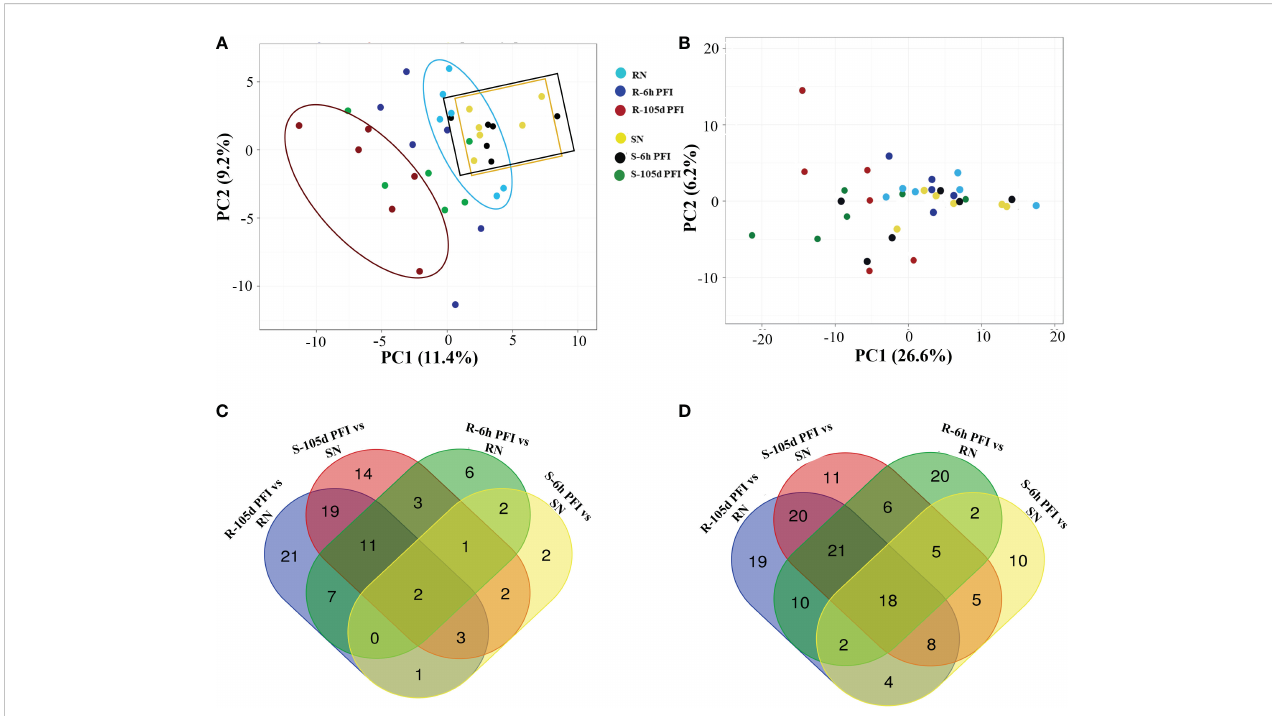
FIGURE 2 The effect of tick infestation on serum and skin proteomes of resistant and susceptible Brangus cattle. Principal component analysis (PCA) of the log 10 protein abundances normalised to a total protein abundance in each group for serum (A) and skin (B) samples; coloured by tick phenotype and the sampling time point: tick resistant naïve (RN) = light sky-blue, tick resistant after 6-hour post- fi rst infestation (R-6h PFI) = blue, tick resistant (R-105d PFI) = red; tick susceptible naïve (SN) = yellow, tick susceptible after 6-hour post- fi rst infestation (S-6h PFI) = black, tick susceptible (S-105d PFI) = green. For PCA with serum samples, the fi rst component (x-axis) accounted for 11.4% of the total variance and the second (y-axis) was 9.2%. For PCA with skin samples, the fi rst component (x-axis) accounted for 26.6% of the total variance and the second (y-axis) was 6.2%. Venn diagrams of the number of proteins signi fi cantly (P<10 − 5 ) different in abundance in serum (C) and skin (D) samples from different